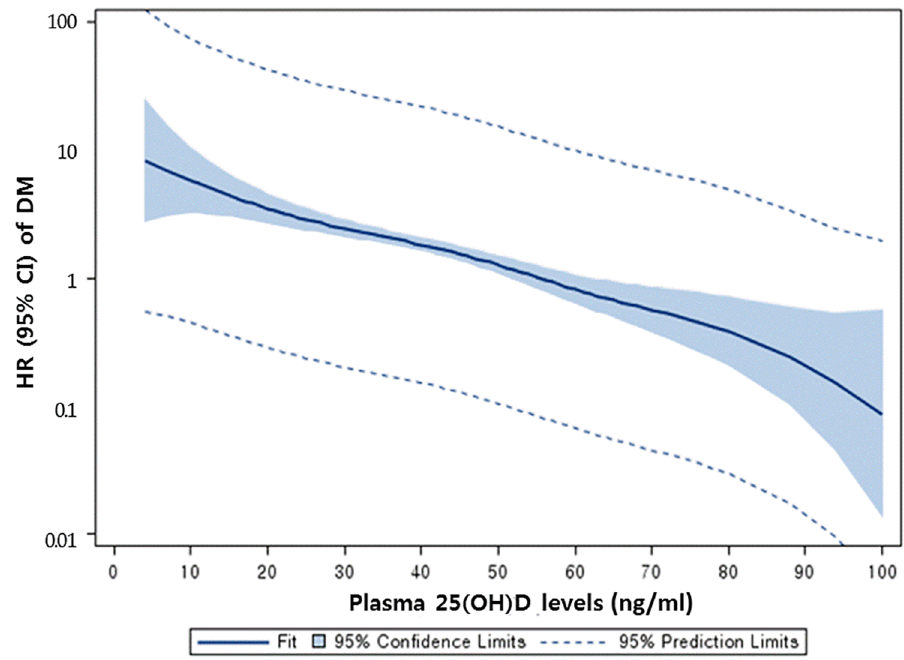
Fig 1. Hazard ratio for type 2 diabetes according to plasma 25(OH)D concentration at baseline, Rancho Bernardo CA, 1997–2009.